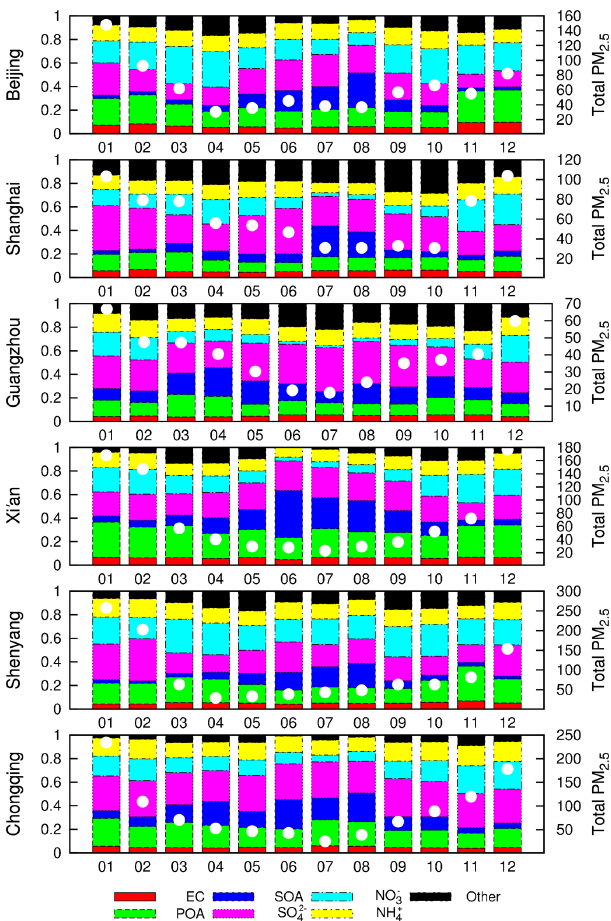
Figure 10. Comparison of PM 2 . 5 components at episode days (Ep, > = 75µgm − 3 ) and non-episode days (non-EP, < 75µgm − 3 ) . White circles are absolute concentrations according to right y axis with unit of µgm − 3 . Note Xi’an does not have episode days in sum-